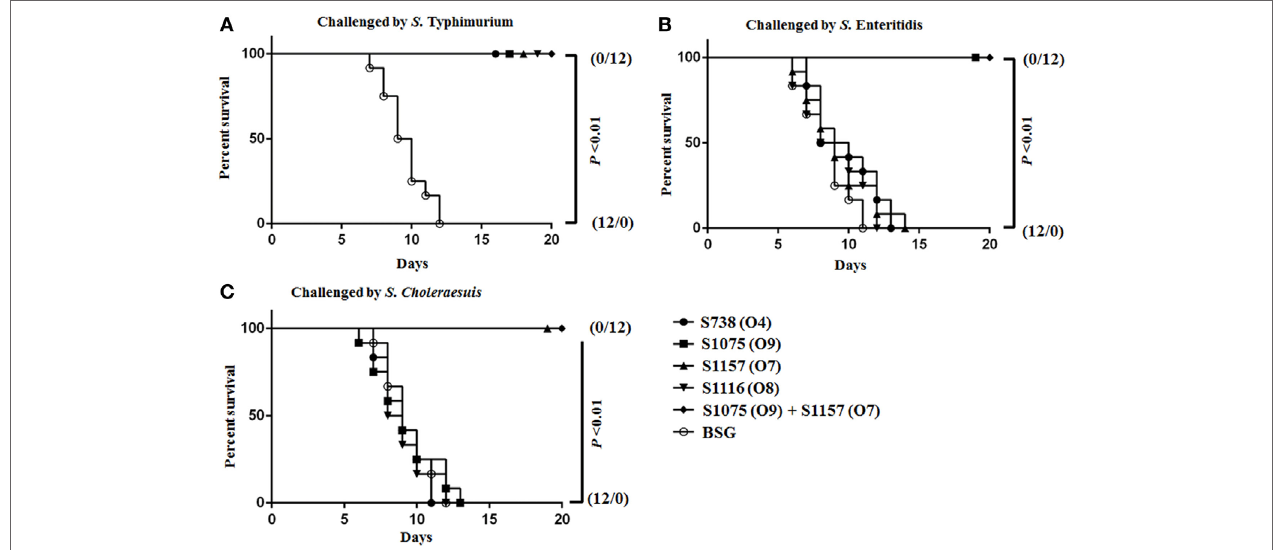
FigUre 6 | Survival curves after orally challenged by wild-type virulent Salmonella. Eight weeks after vaccination, BALB/c mice were challenged by about 100 times the LD 50 of wild-type virulent S. Typhimurium (a) , S. Choleraesuis (B) , and S. Enteritidis (c) . P < 0.01, for all marked group versus BSG